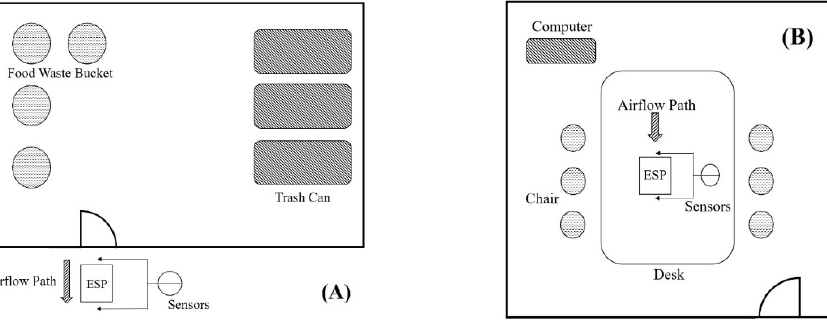
Figure 3. Site plan of the field test on ( A ) food waste storage room and ( B ) meeting room.